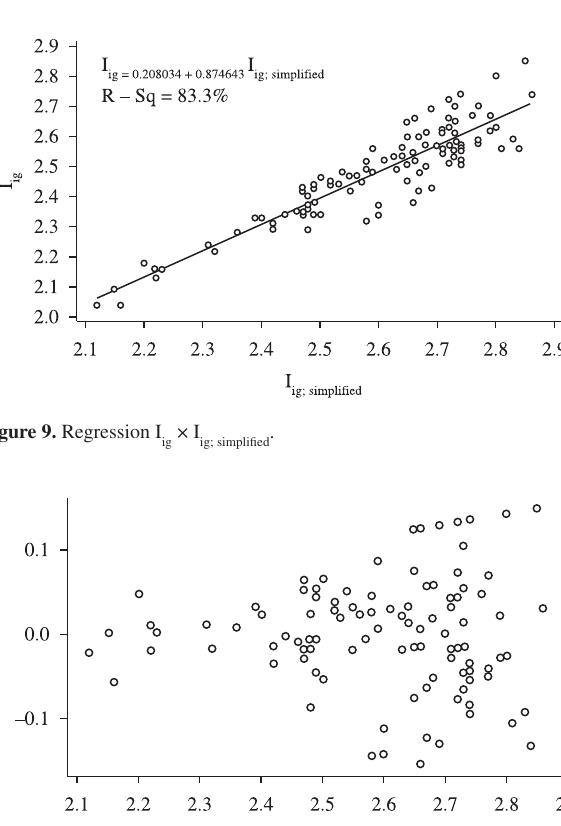
and I ig ig; simplified